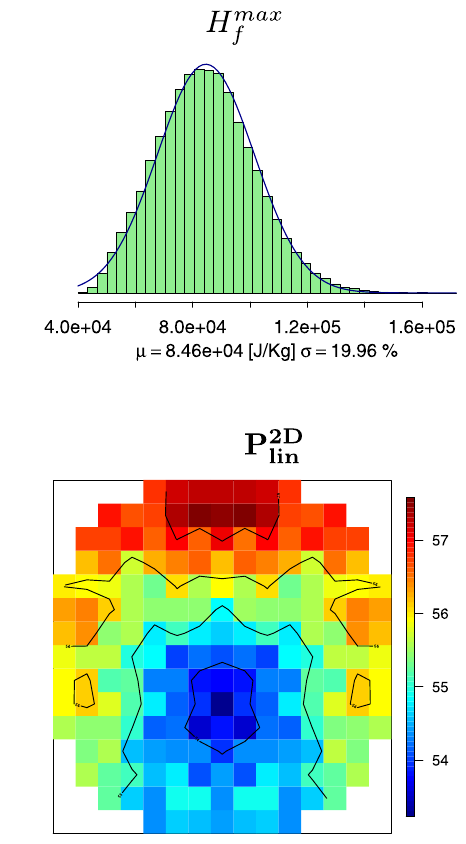
Fig. 5. P max and DNB min histograms and P 2 D , H max f lin